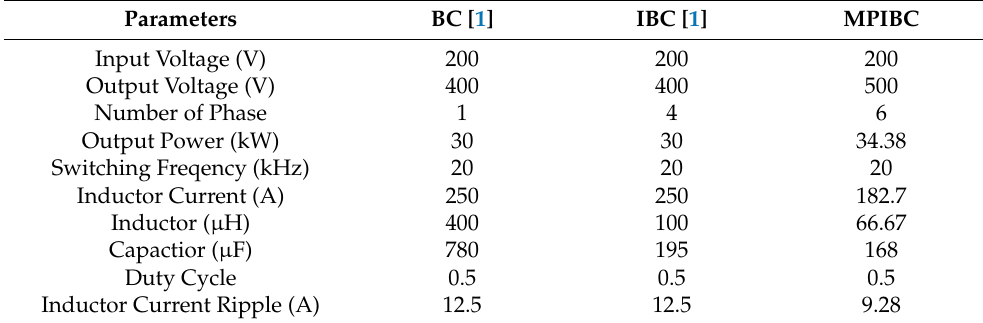
Table 9. MPIBC comparison with existing converter.